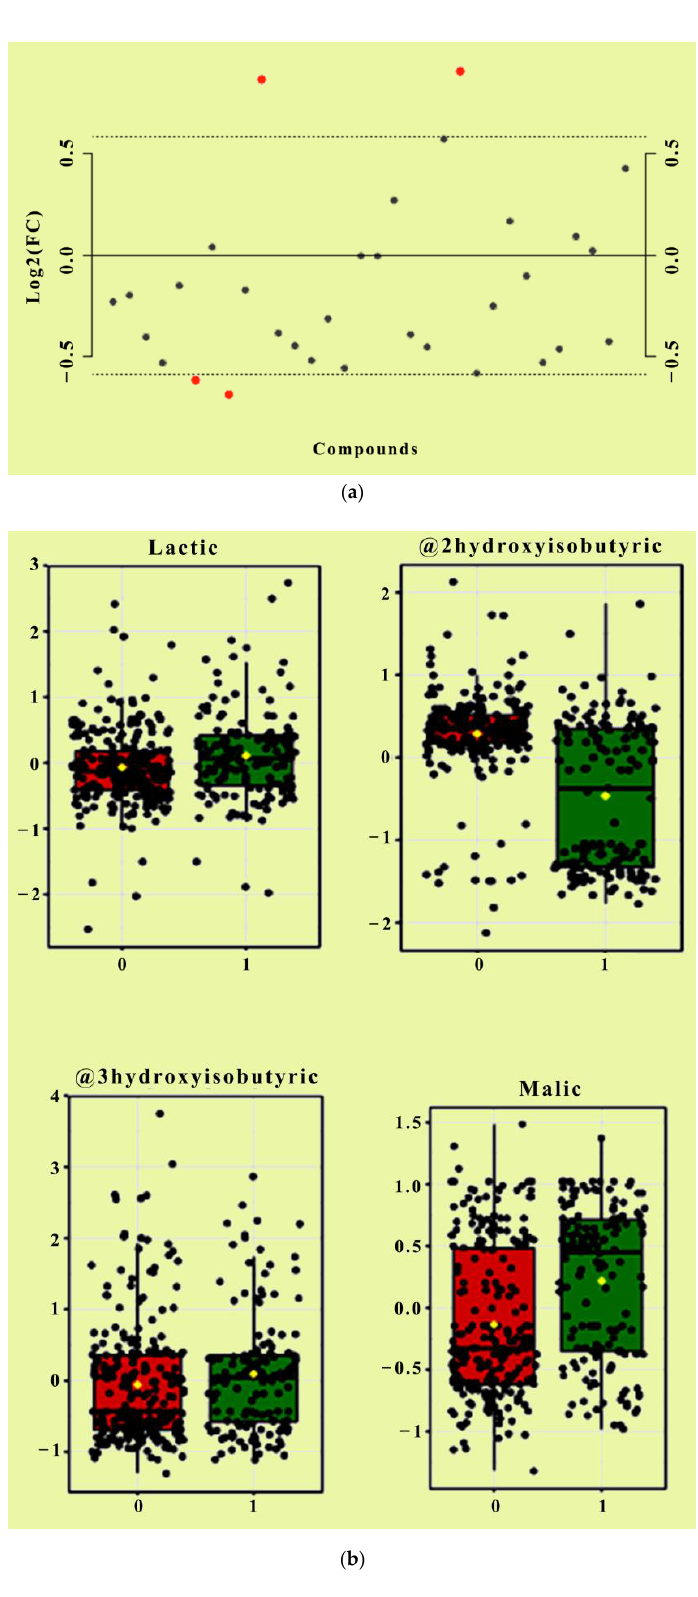
Figure 2. Fold Change Analysis of the organic acid metabolic compounds between the two groups (FDR < 0.05, fold change (FC) > 1.5). Red dots indicate significantly di ff erent variables in relation to control ( a ). Bar plots show the untransformed values (mean ± SD) where “1” indicates the control group (red) and “0” indicates the AD group (green) ( b